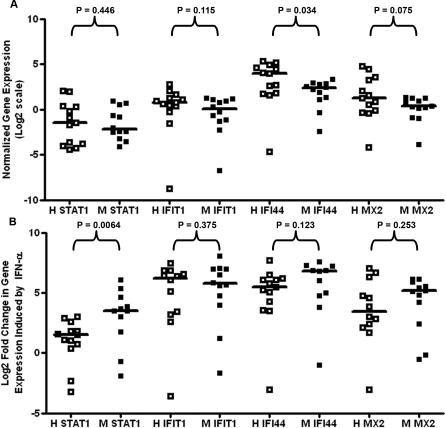
Expression of ISGs in Lymphocytes from Patients with Melanoma and Healthy Donors Stimulated with IFN-αLymphocytes from patients with melanoma and healthy controls were stimulated with 1,000 IU/ml for 14 h. The expression of STAT1, IFIT1, IFI44, and MX2 were measured by qPCR. Data are shown on a log2 scale. Medians are indicated by the bar in each scatter column. p-Values are from one-sided Wilcoxon rank sum test. H, healthy; M, melanoma.(A) Gene expression in IFN-α-stimulated cells, sample sizes were n = 13 (H) and n = 12 (M) for each gene.(B) Fold change in gene expression in IFN-α–stimulated cells versus unstimulated control cells. STAT1: n = 13 (H), n = 11 (M); IFIT1: n = 12 (H), n = 12 (M); IFI44: n = 13 (H), n = 11 (M); MX2: n = 12 (H), n = 12 (M).